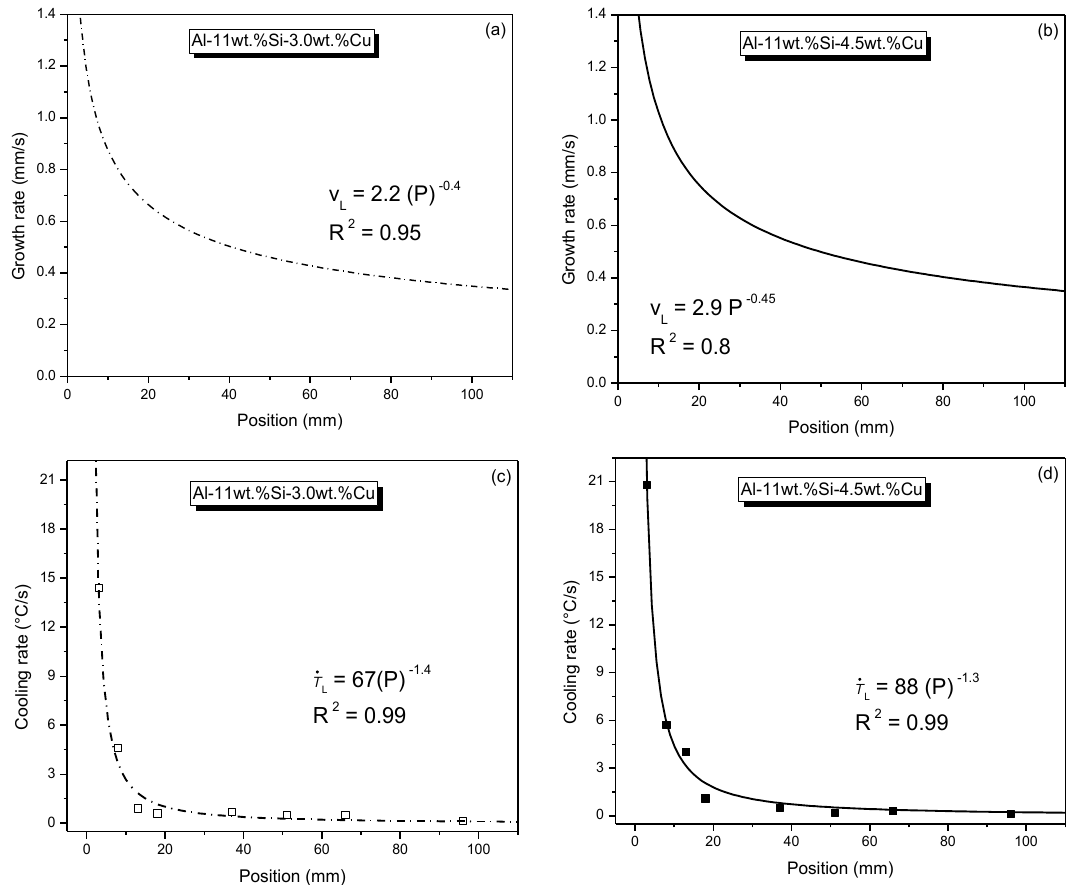
Figure 5. Experimental variations of ( a , b ) growth rate and ( c , d ) tip cooling rate during unsteady state directional solidification of the ternary Al-11Si- x Cu alloys. R 2 is the coefficient of determination. Figures 6 and 7 present the optical micrographs of the Al-11wt %Si-3.0 and 4.5wt %Cu braze alloy samples. In the micrographs, the aluminium-rich dendrites can be seen being enveloped by the products of the eutectic reactions; that is, the Al–Si eutectic and the Al–Si–Al 2 Cu ternary eutectic. The micrographs refer to different positions along the length of the DS castings. Very fine to large length-scales of the formed dendritic structures can be observed. This is explained due to the wide range of experimental solidification cooling rates experienced across the fabricated DS